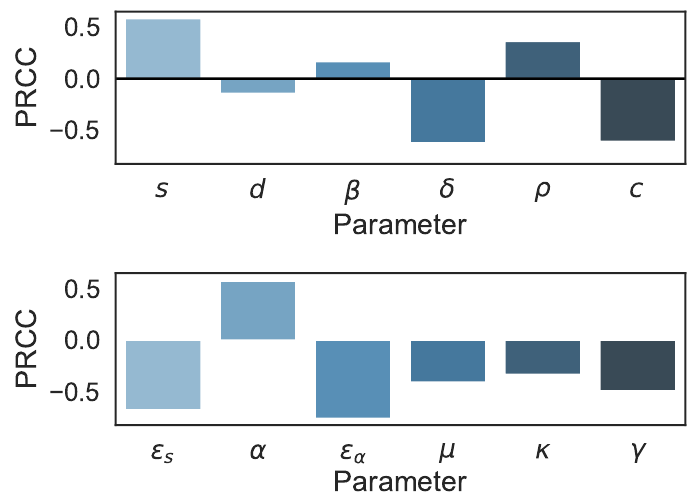
Figure 2. PRCC results of the multiscale